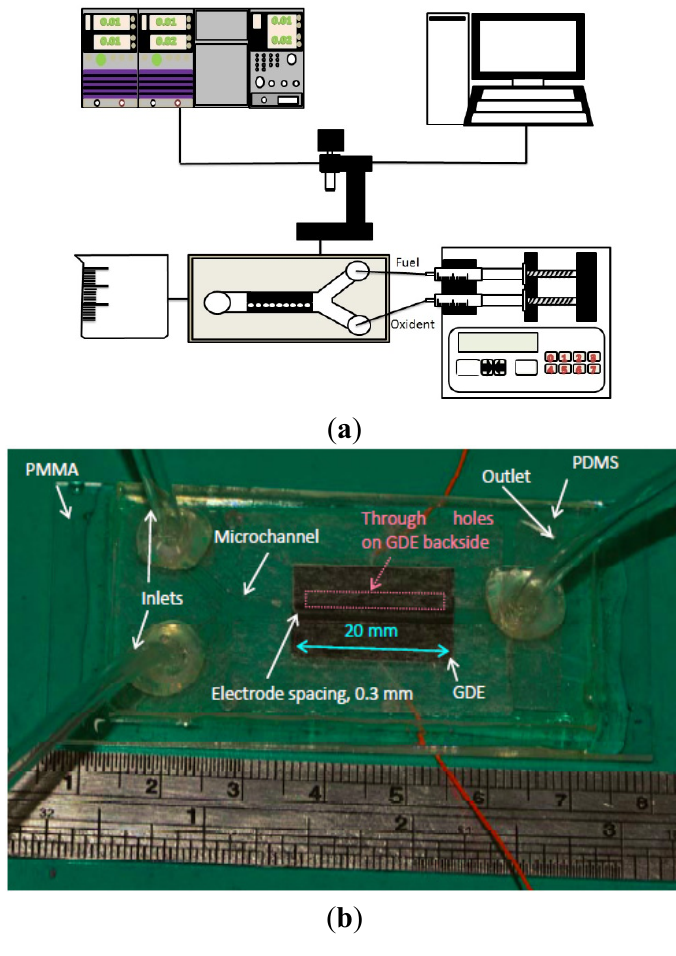
Figure 1. ( a ) Experimental apparatus; ( b ) the microfluidic fuel cell of the